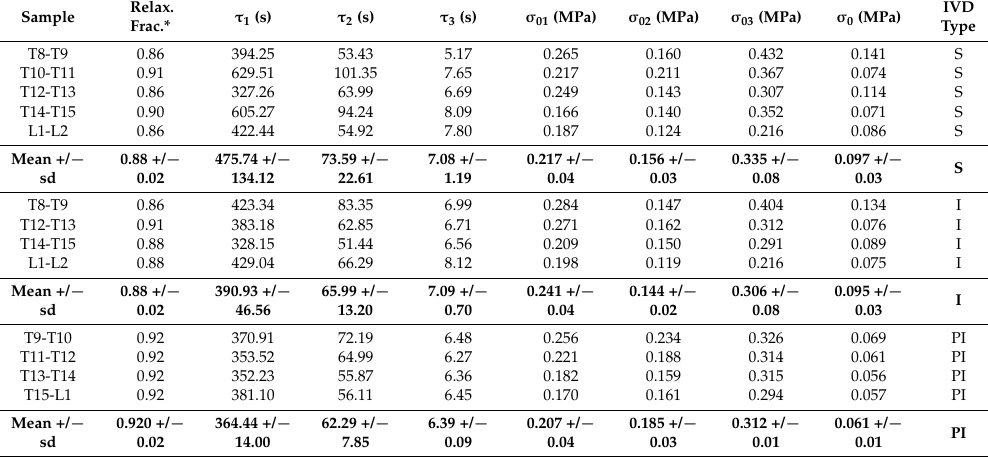
Table 3. Compression stress relaxation modeling parameters for different intervertebral discs of a growing-finishing pig: (S) non-injected healthy discs; (I) mechanically tested and then injected discs; and (PI) disc pre-injected before mechanical test. The analysis was performed according to a three branch Maxwell element, according to the relaxation law: σ ( t ) = σ 0 + σ 01 · e − t / τ 1 + σ 02 · e − t / τ 2 + σ 03 · e − t / τ 3 .